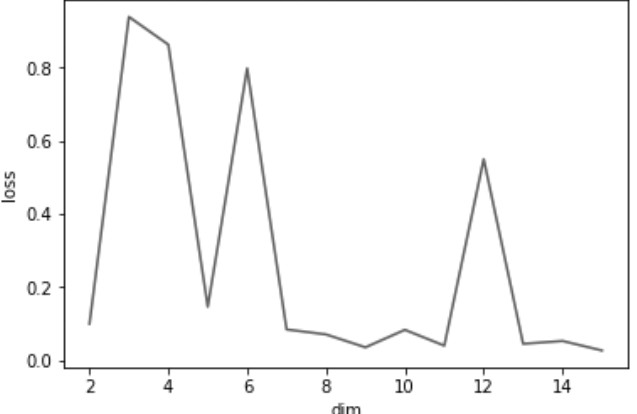
Figure 6. The dependence of the autoencoder loss function value from the dimension of encoder after training on the full dataset. The y axis represents the value of the loss function, the x axis represents the number of neurons in the hidden layer. The best result is achieved with the number of neurons equal to 15.